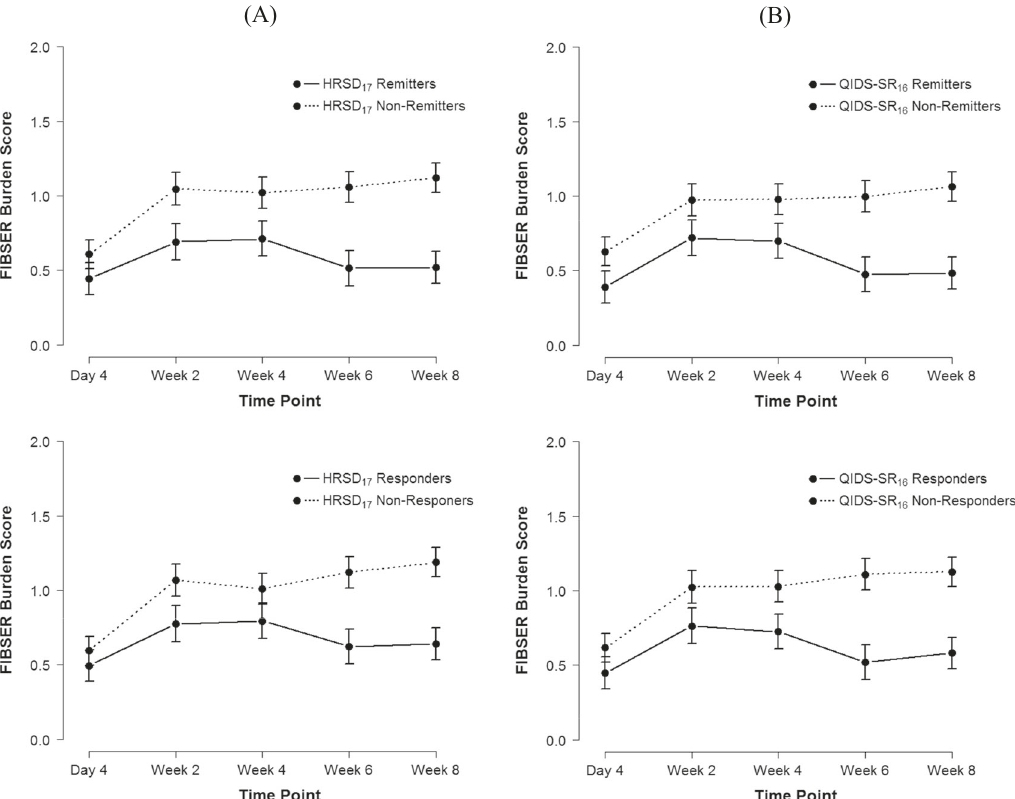
Fig. 2 Mean FIBSER burden score trajectories for remitters and responders. A HRSD 17 and B QIDS-SR 16 remitters and responders. Note: Error bars represent 95% con fi dence intervals of the